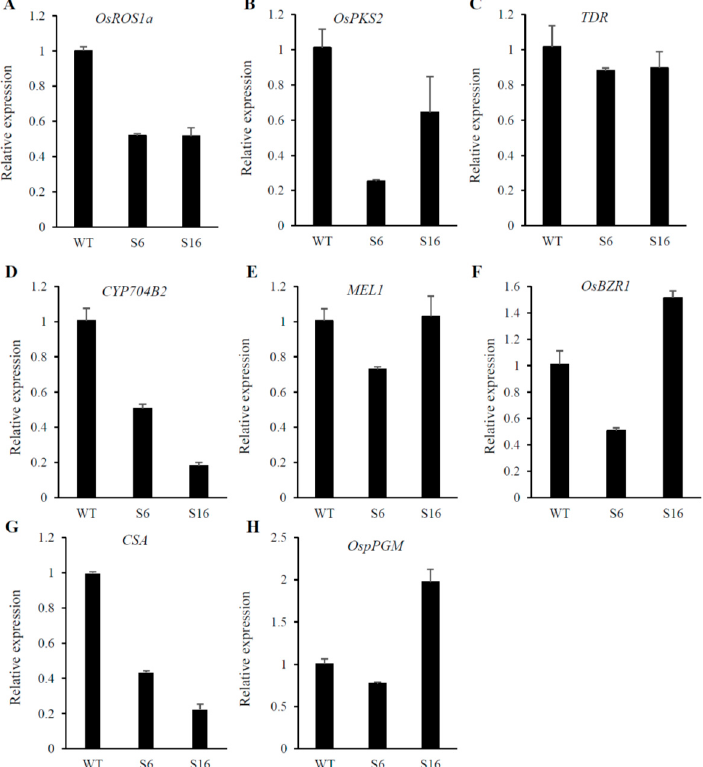
Figure 8. Expression patterns of anther and pollen development-related genes ( A – E ) and starch synthesis-related genes were analyzed by qRT-PCR. The young panicles (at stage 10, the vacuolated pollen stage) of WT, osros1a S6 and S16 mutants were sampled for RNA extraction. Data are shown as means ± standard deviations, and OsACTIN was used as an internal control.